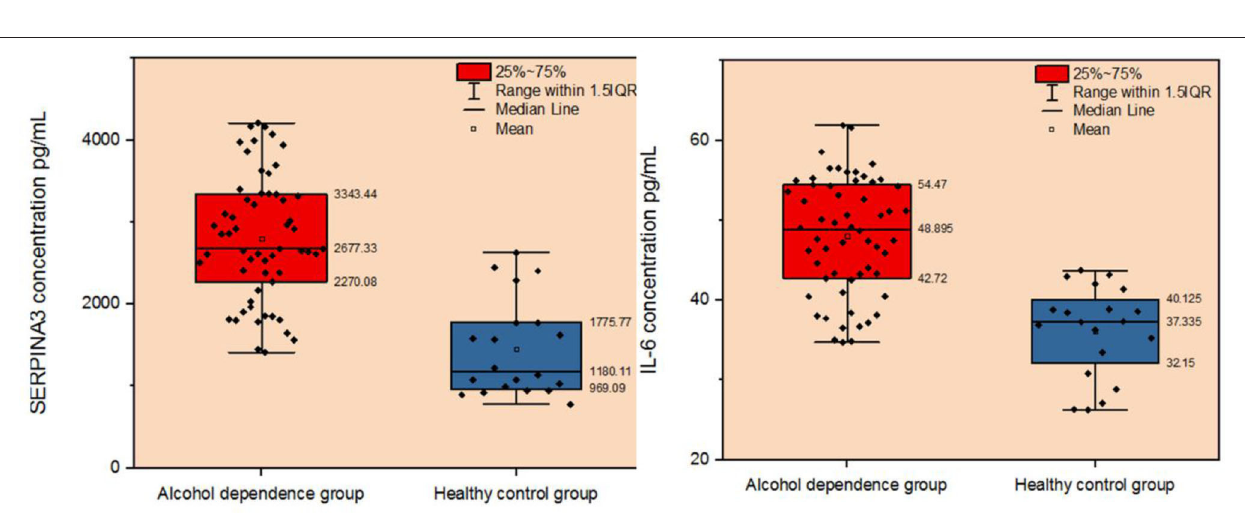
FIGURE 5 | Comparison of plasma SERPINA3 and IL-6 levels between patients with alcohol dependence and the healthy control group.